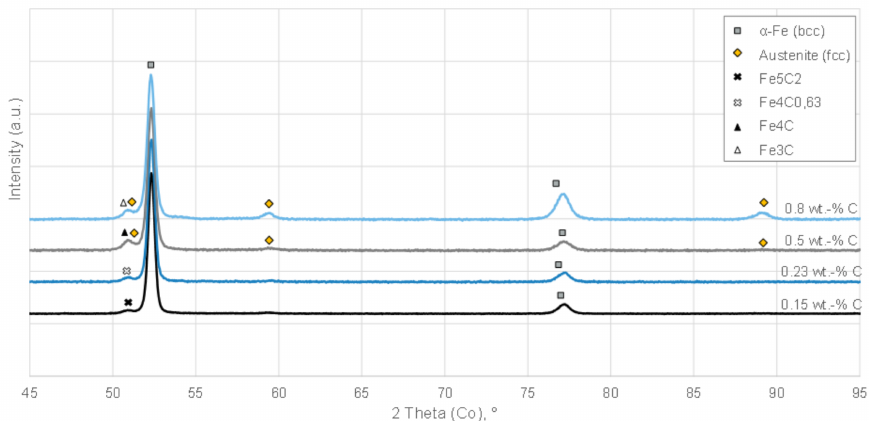
Figure 6. X-ray diffraction pattern at varied carbon content showing retained austenite at 0.8 wt.% carbon content (bcc: body-centred cubic; fcc: face-centred cubic).